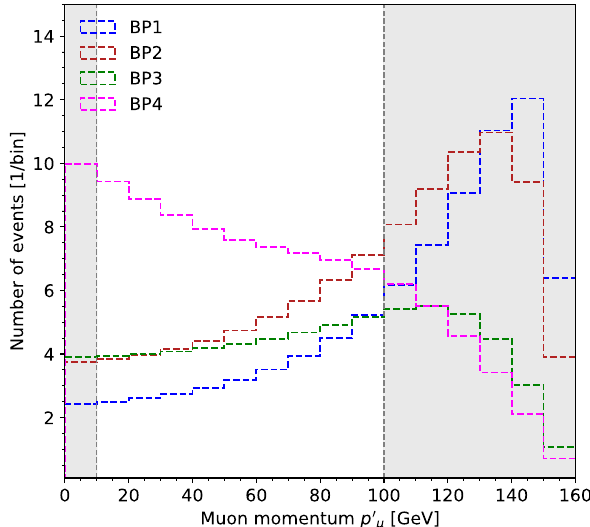
Fig. 4 Muon spectrum at NA64 μ due to an invisibly decaying U ( 1 ) L μ − L τ A (cid:5) signal at the benchmark points of Table 1. The grey shaded areas show the experimental energy cut applied in the measure- ment in order to remove any